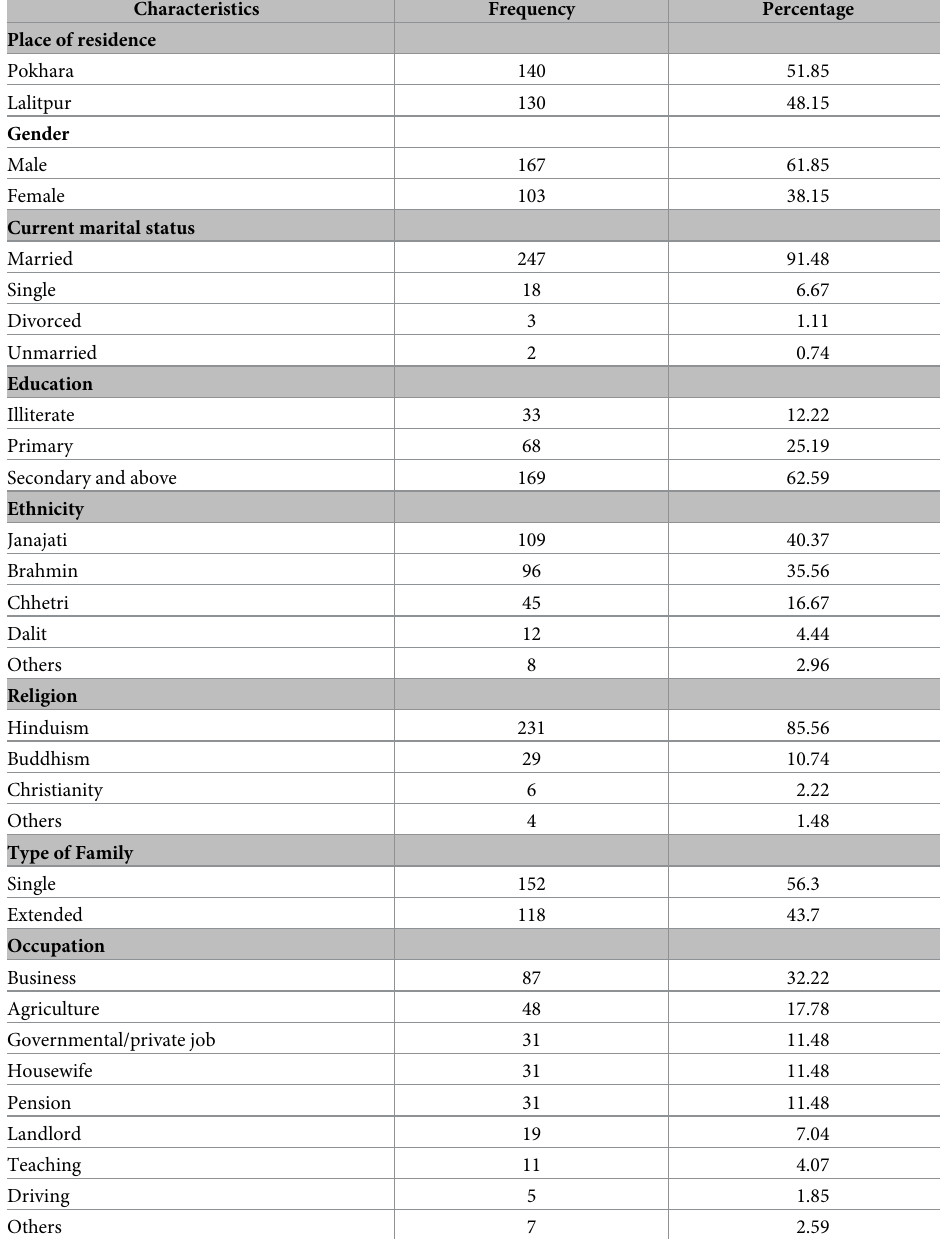
Table 1. Socio-demographic characteristics of urban Nepalese diabetic patients (n = 270).